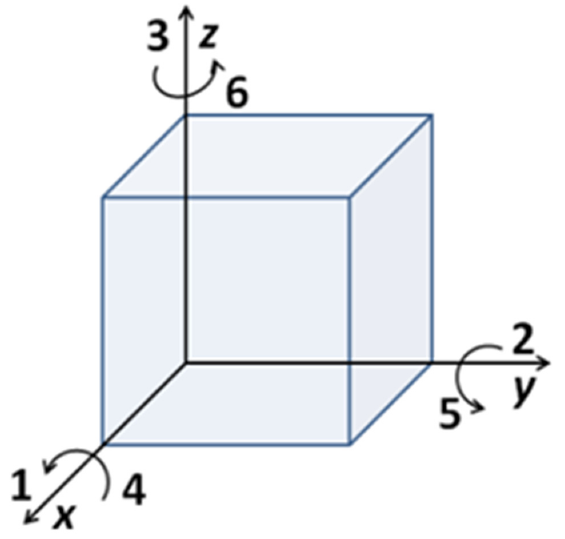
Figure 1. Directions of the polarization and the applied stress.